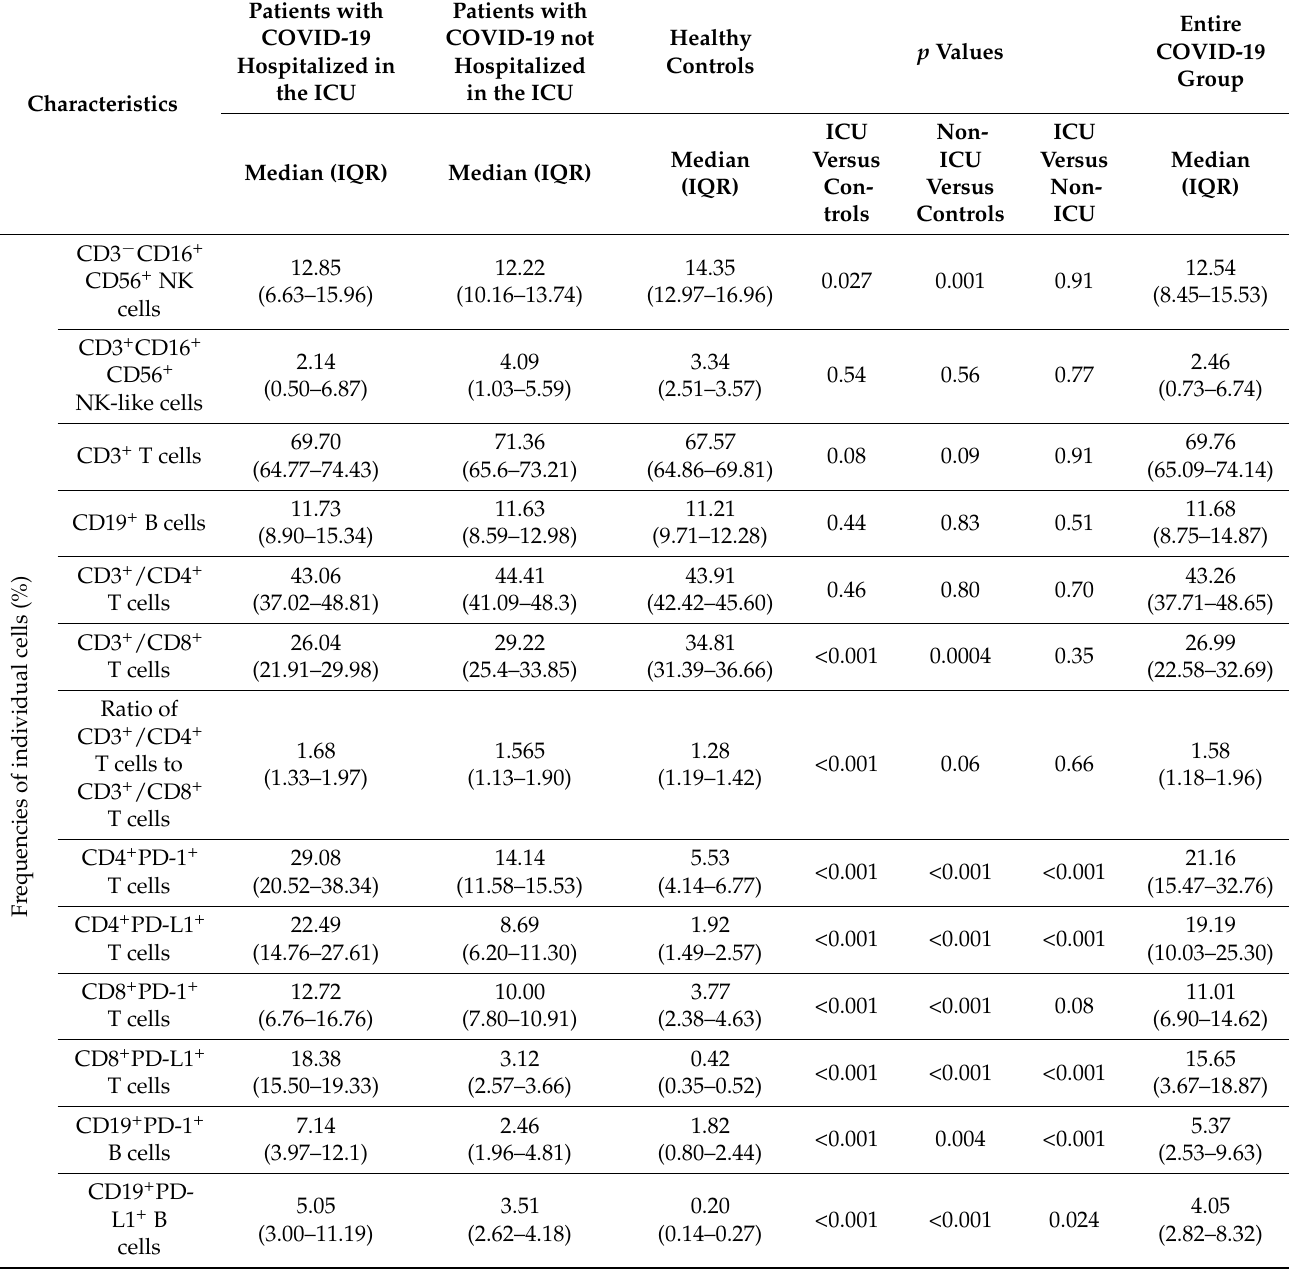
Table 2. Immunophenotypes of COVID-19 cases at baseline (day 0 of in-hospital treatment) compared with healthy